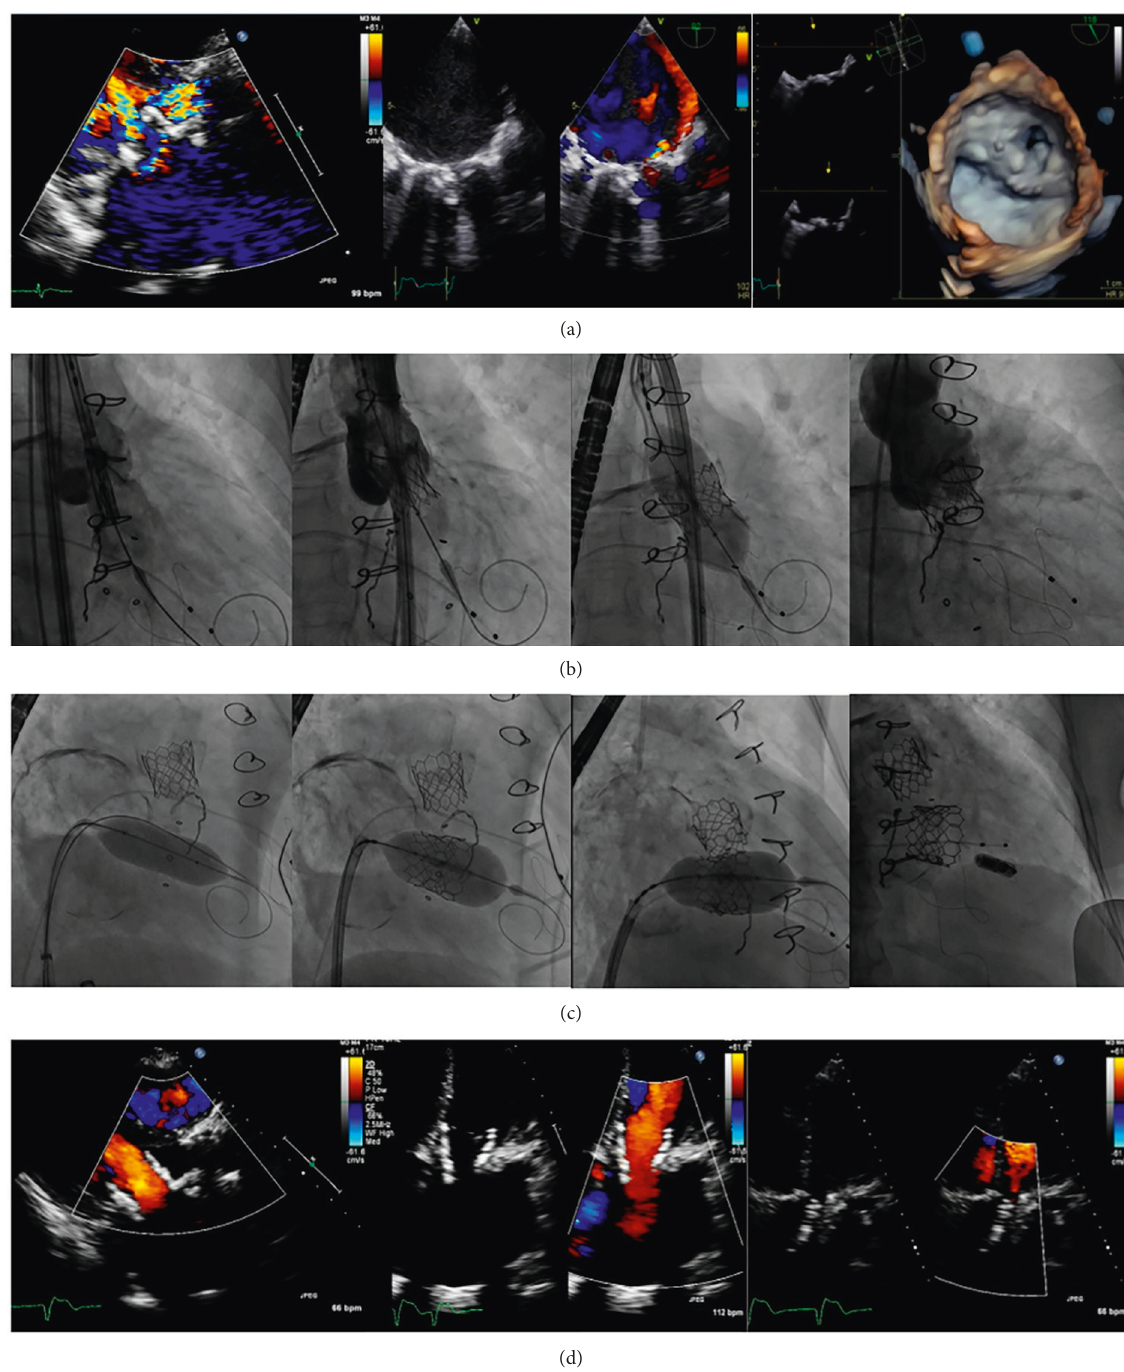
Figure 2: Transcatheter mitral valve in a degenerated Mosaic ® ultra ™ (Medtronic) valve (TMViV) with a concomitant transcatheter aortic valve implantation (TAVI). A 51-year-old male patient had a degenerated 23-mm Mosaic ® ULTRA ™ bioprosthetic MV (Medtronic) and a degenerated calcific AV with an associated AF. (a) TTE, TEE, and 3D-TEE show a degenerated bioprosthetic MV (severe MS and severe MR) and a calcific degenerated AV (severe AS and severe AR). (b) Fluoroscopy shows a transaortic TAVI of an Edward SAPIEN-3 26mm valve during rapid pacing. (c) Fluoroscopy shows pre-TMViV balloon dilatation using a CRISTAL, BALT balloon 22mm over a 0.035-inch/260 extra-stiff Confida ™ guidewire. Then, transseptal TMViV of an Edwards SAPIEN-3 23mm valve with post-TMViV distal valve flaring, followed by transseptal implantation of a wireless pacemaker as the patient developed CHB. (d) TTE: both SAPIEN-3 valves are in mitral and aortic positions with normal flow across both valves. AF: atrial fibrillation, AR: aortic regurgitation, AS: aortic stenosis, AV: aortic valve, CHB: complete heart block, 3D: three-dimensional, MR: mitral regurgitation, MS: mitral stenosis, MV: mitral valve, MVA: mitral valve area, Pg: pressure gradient, TAVI: transcatheter aortic valve implantation, TMViV: transcatheter mitral valve-in-valve, TEE: transesophageal echocardiography, and TTE: transthoracic